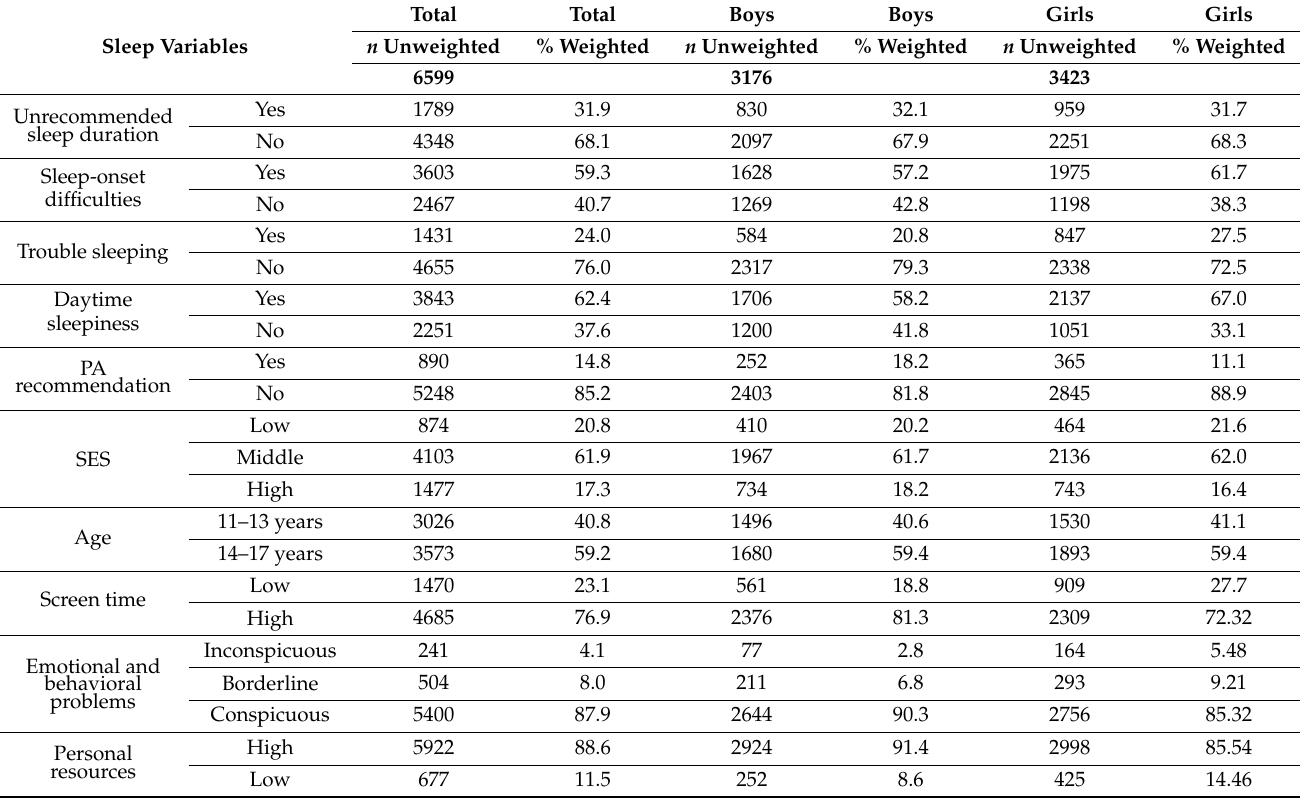
Table 1. Description of study sample by